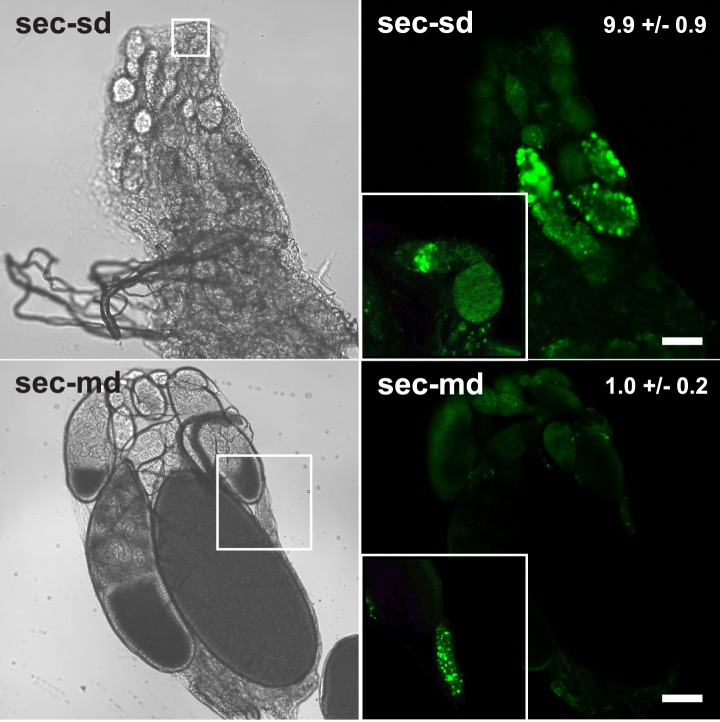
Apoptosis in D. sechellia ovaries.Confocal fluorescent images (right) and light transmission images (left) of D. sechellia (14021–0248.25, sec) ovaries of flies fed a standard diet (sd) (top) or morinda diet (md) (bottom), stained with the vital die acridine orange to label apoptosis (Arama and Steller, 2006). The number of apoptotic cysts per ovary (average ± s.e.m.) is indicated for a standard diet (N = 11) and morinda diet (N = 10). Insets show in detail apoptosis occurring at the germanium (top) and an example of the occasional apoptotic cysts in ovaries of flies fed morinda (bottom). Scale bar 20 μm.